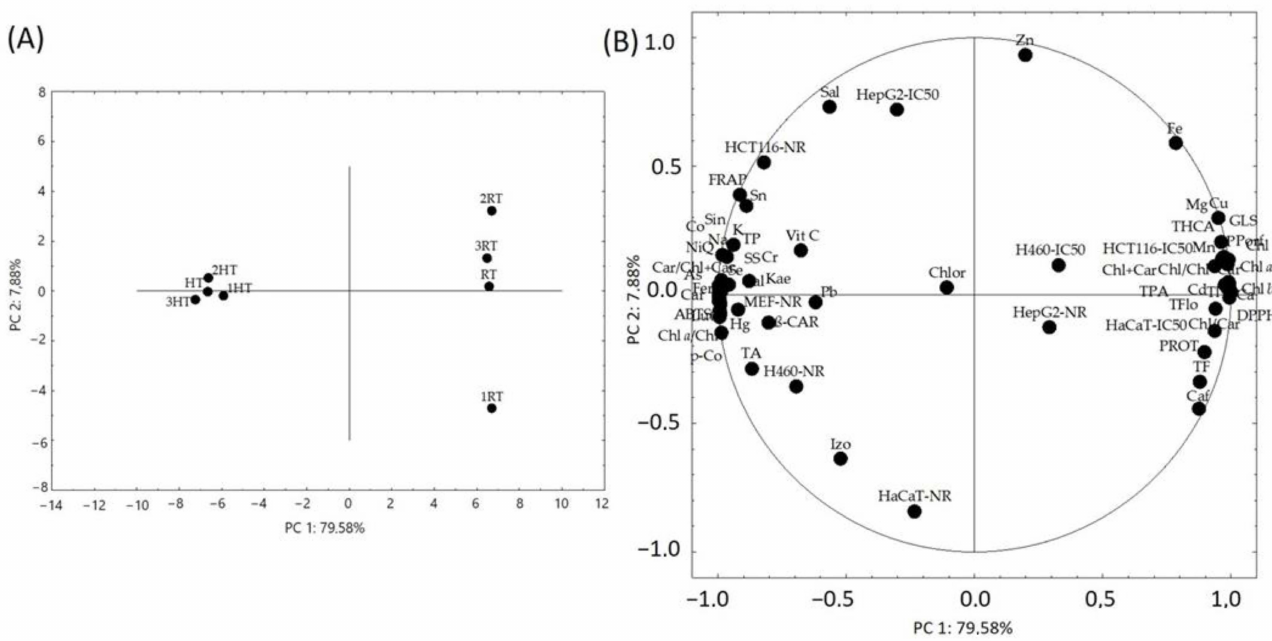
Figure 3. Principal component analysis of the groups of broccoli seedlings: ( A ) score plot separating the samples based on the measured phytochemicals (individual and groups), macro- and microele- ments, antioxidant capacity, and in vitro cytotoxicity, and ( B ) loading plot of the measured variables. Hierarchical clustering confirmed the separation of control and stressed broccoli seedlings (Figure 4). Namely, all the replicas of room temperature grown broccoli seedlings formed one cluster, and all the replicas of high temperature grown broccoli seedlings formed another one.